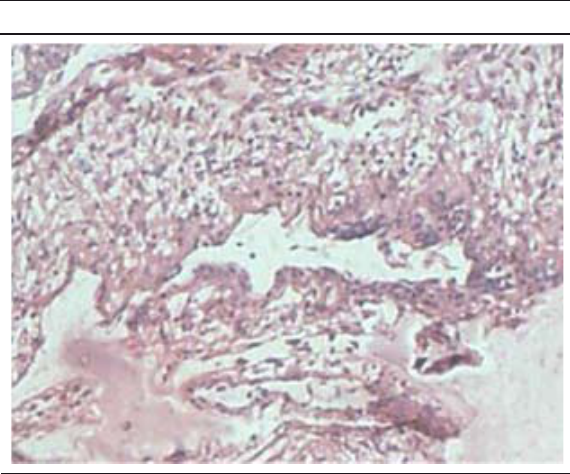
Figure 4. histopathological picture consistent with arachnoid